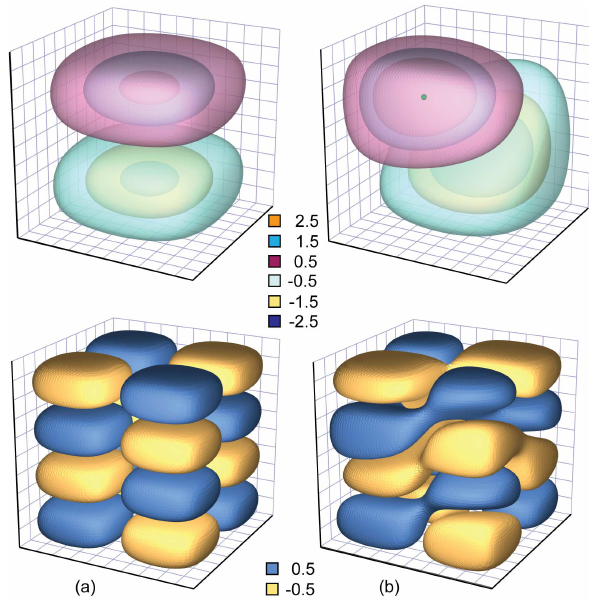
Figure 1: Wave functions of electronic states (112) and (224) inside a 3.4×3.8×4.2 nm 3 nanocuboid (a) without and (b) with an impu- rity ion located at point x = 0.68 nm, y = 0.76 nm, and z = 0.84 nm (shown by dot). For visualization purpose, an ion of charge +10 e is used. The wave functions are normalized by the volume of the